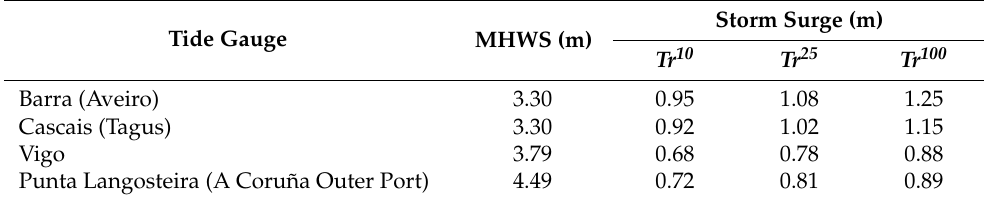
Table 2. Mean high water springs (MHWS) and storm surge for each return period referred to the mean sea level at each tide